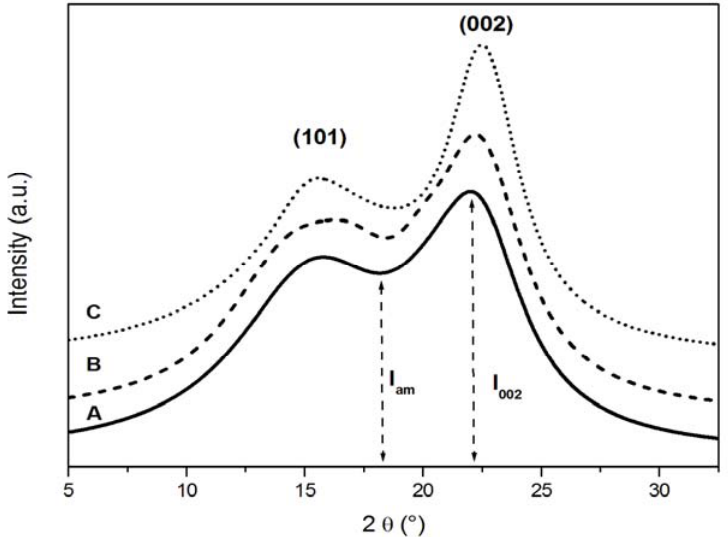
Figure 1. X-ray diffraction (XRD) diffractograms of uncoated wood samples. ( A ) control; ( B ) sample exposed to natural weathering; ( C ) sample artificially